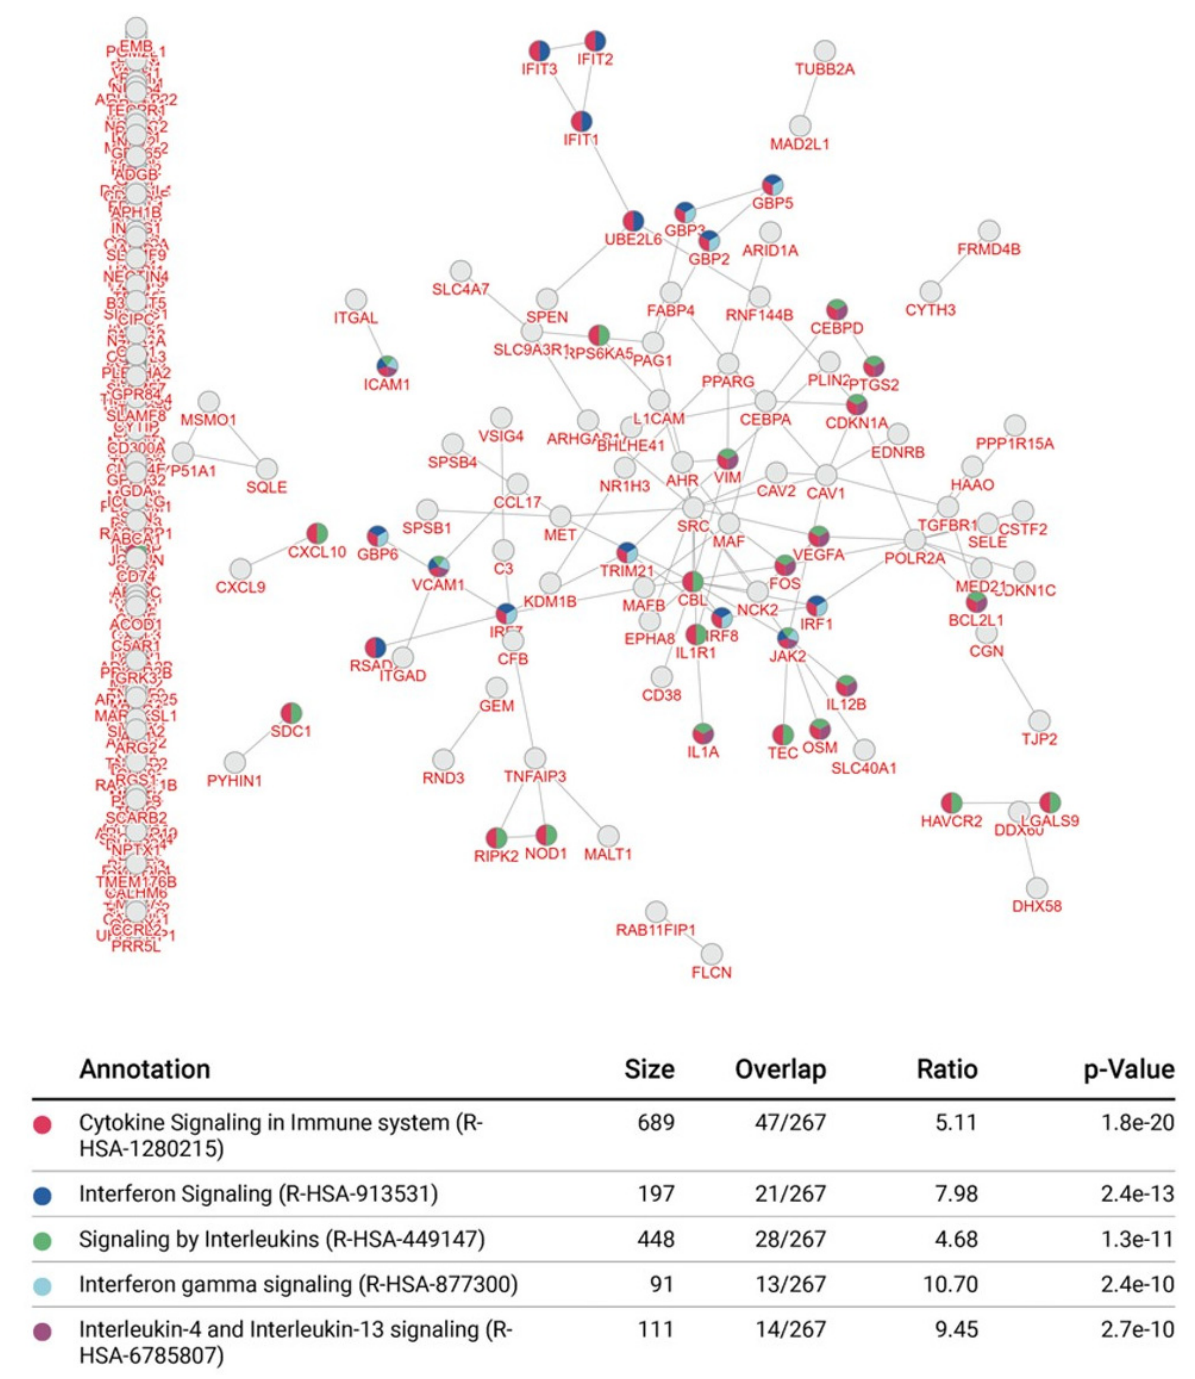
Figure 5. Integrative pathway enrichment analysis in p65 ‐ DsRed/I κ B α‐ eGFP BMDMs. The enrichment map and data table indicate the top 5 prognostic signalling pathways identified using all 363 differentially expressed genes identified in unstimulated and Lipid A ‐ stimulated (100 ng/mL, at 1, 3 and 6 h) p65 ‐ DsRedxp/I κ B α‐ eGFP BMDMs. Interactions are indicated by connecting lines and multi ‐ coloured nodes indicate pathways that were prognostic according to several types of molecular evidence. Data outputs were generated using the inBio Discover™ tool (www.inbio ‐ dis ‐ cover.com/ (accessed on 16 January 2022)) and no relevance score cut ‐ off was used.